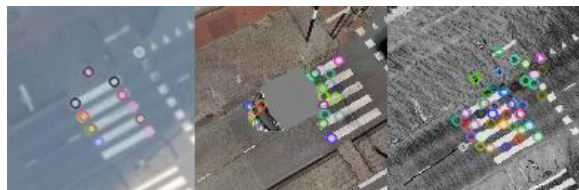
Table 1 Number of combined keypoints over all subsets per